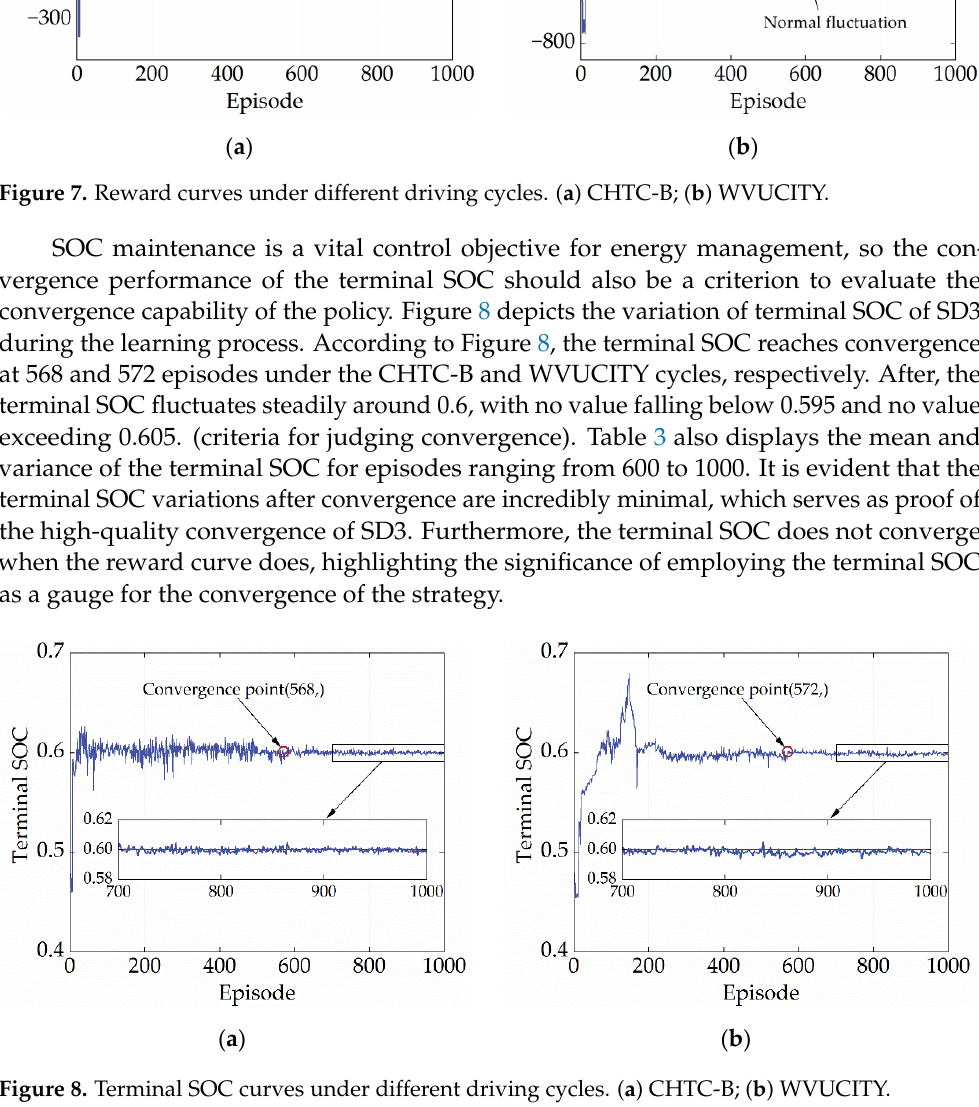
Figure 8. Terminal SOC curves under different driving cycles. ( a ) CHTC-B; ( b ) WVUCITY. Table 3. Statistics of the terminal SOC. Table 3. Statistics of the terminal